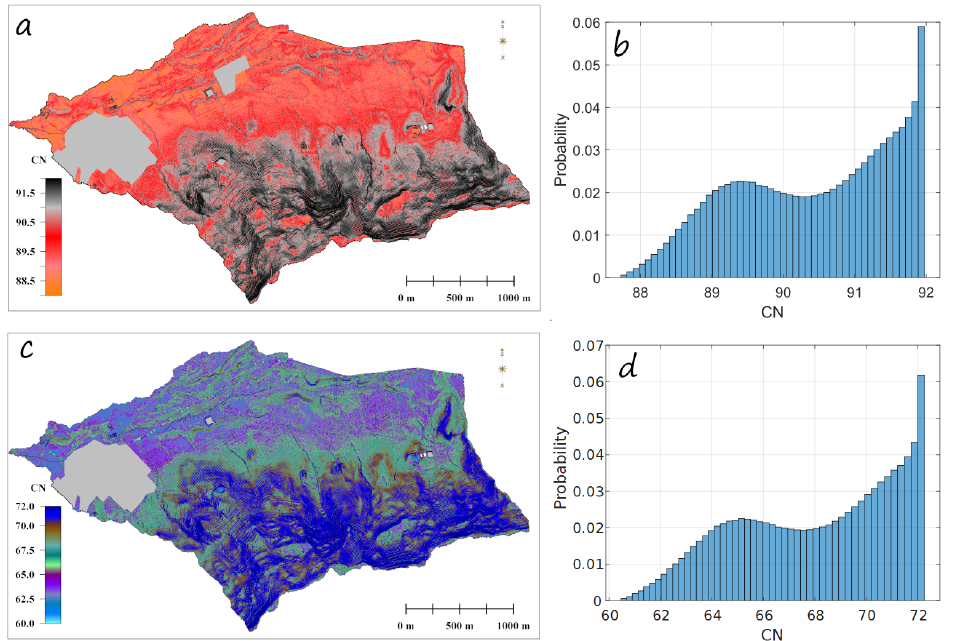
Figure 5. Map and histogram of the local values of the Curve Number (CN) for the simulation setups CN64 ( a , b ) and CN89 ( c , d ) in the Arquillos Basin, computed and drawn by the authors using the Methods detailed in Section